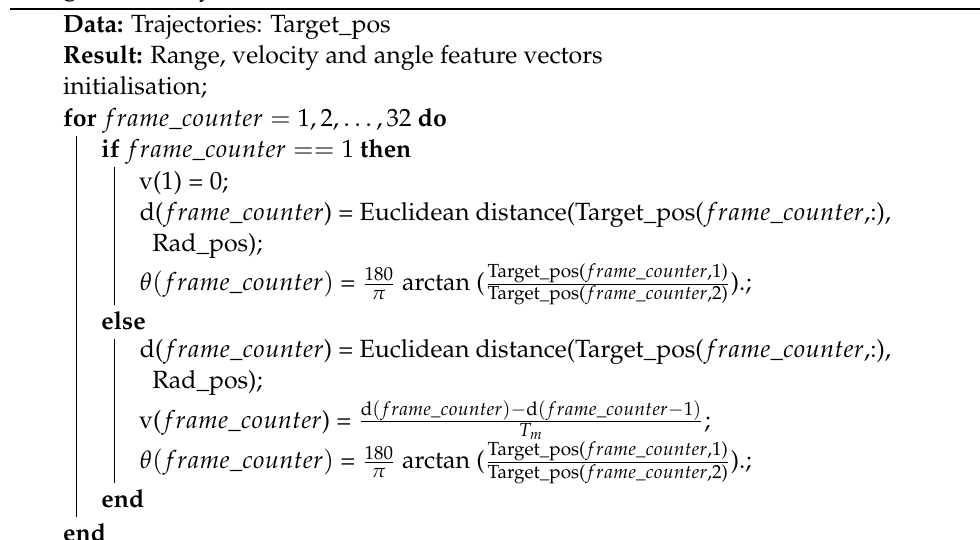
Algorithm 2: Synthetic feature